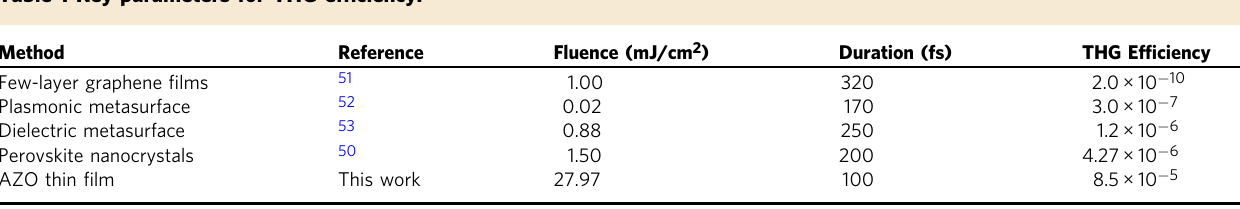
Table 1 Key parameters for THG ef fi ciency.